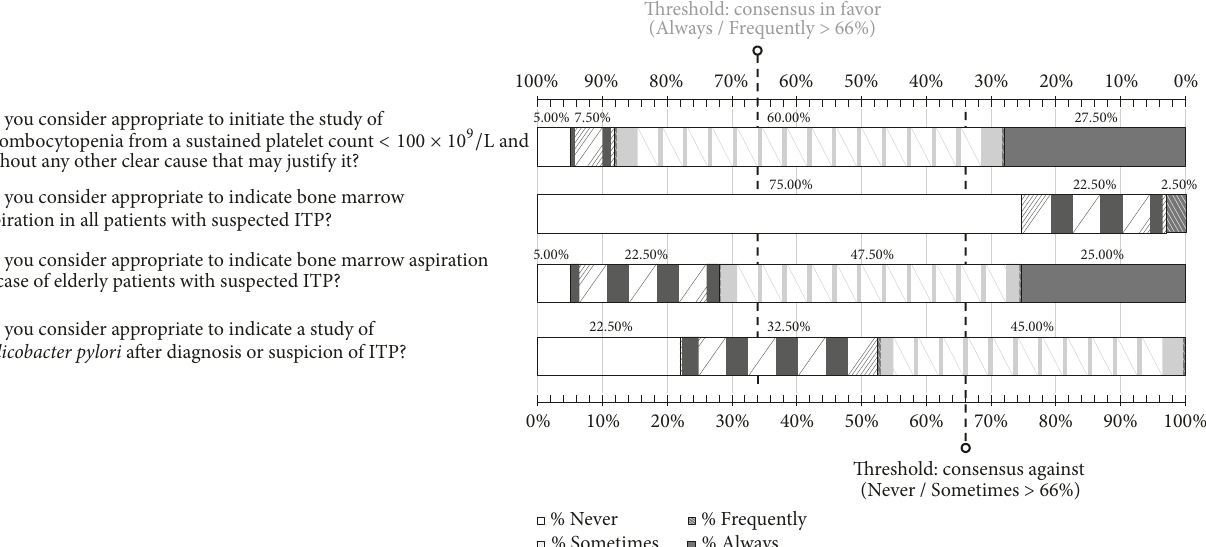
study (participation rate 30.2%) and 39 fully completed